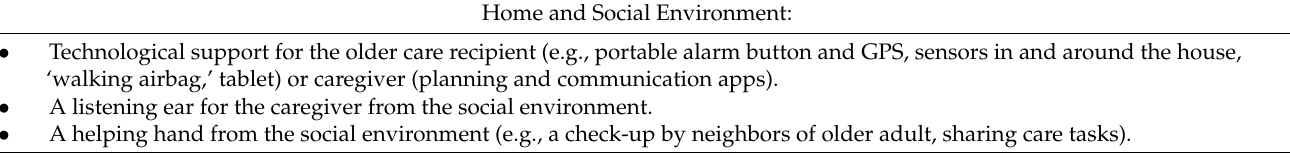
Table 3. Support options in different settings mentioned by caregivers participating in the focus